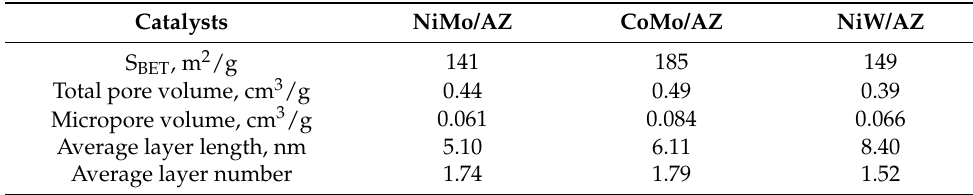
Table 1. Textural properties of the catalysts.